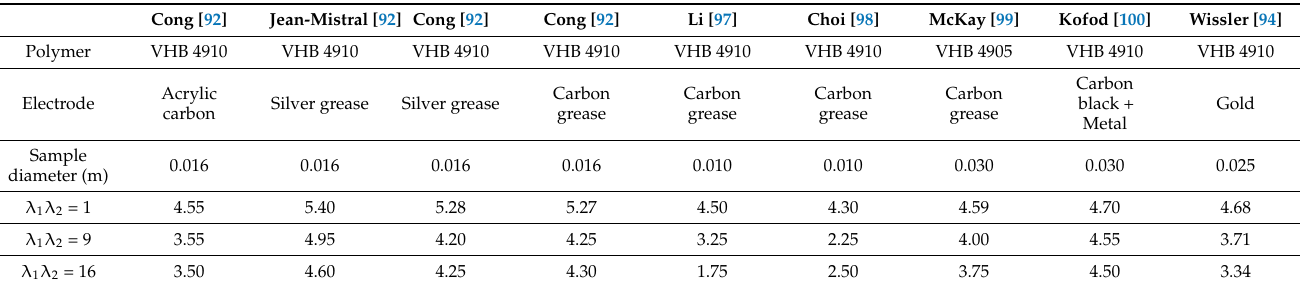
Table 2. Effects of pre-stretch on the dielectric constant, observed in the literature (Reproduced with permission from [92], Copyright IOP Publishing Ltd.,